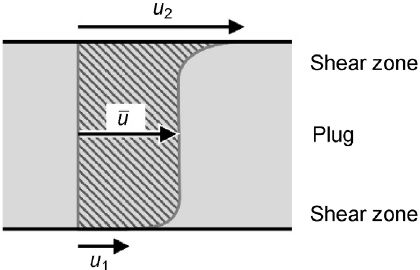
Fig. 11 Scheme of plug flow.